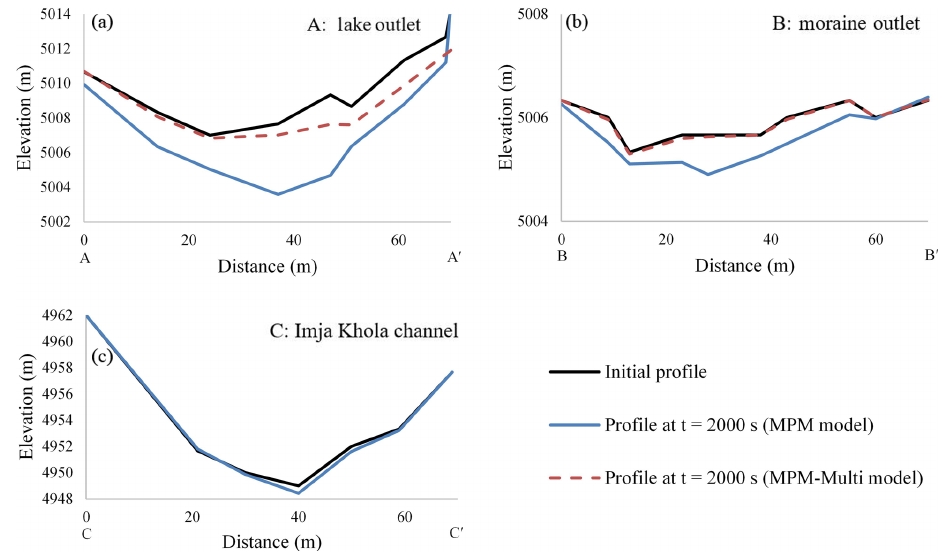
Figure 9. Surface elevation profiles at the start of wave generation (solid black line) from a large southeast avalanche and 2000s after generation at all three cross sections, for both the MPM model (solid blue line) and the MPM-Multi model (dashed red line), at the lake outlet (A), moraine outlet (B), and Imja Khola channel (C) transects shown in Fig. 7. Note the smaller scale of (B). The MPM-Multi model at (C) lacked measurable erosion and is not